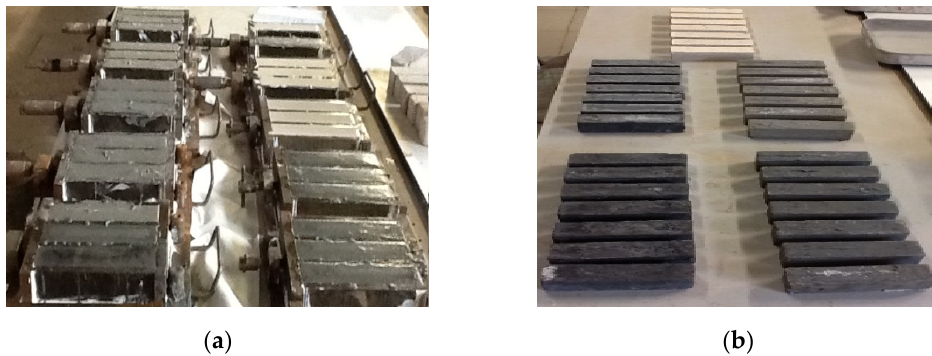
Figure 2. Preparation of grout specimens: ( a ) specimen molds after filling with grout; ( b ) grout specimens after demolding.